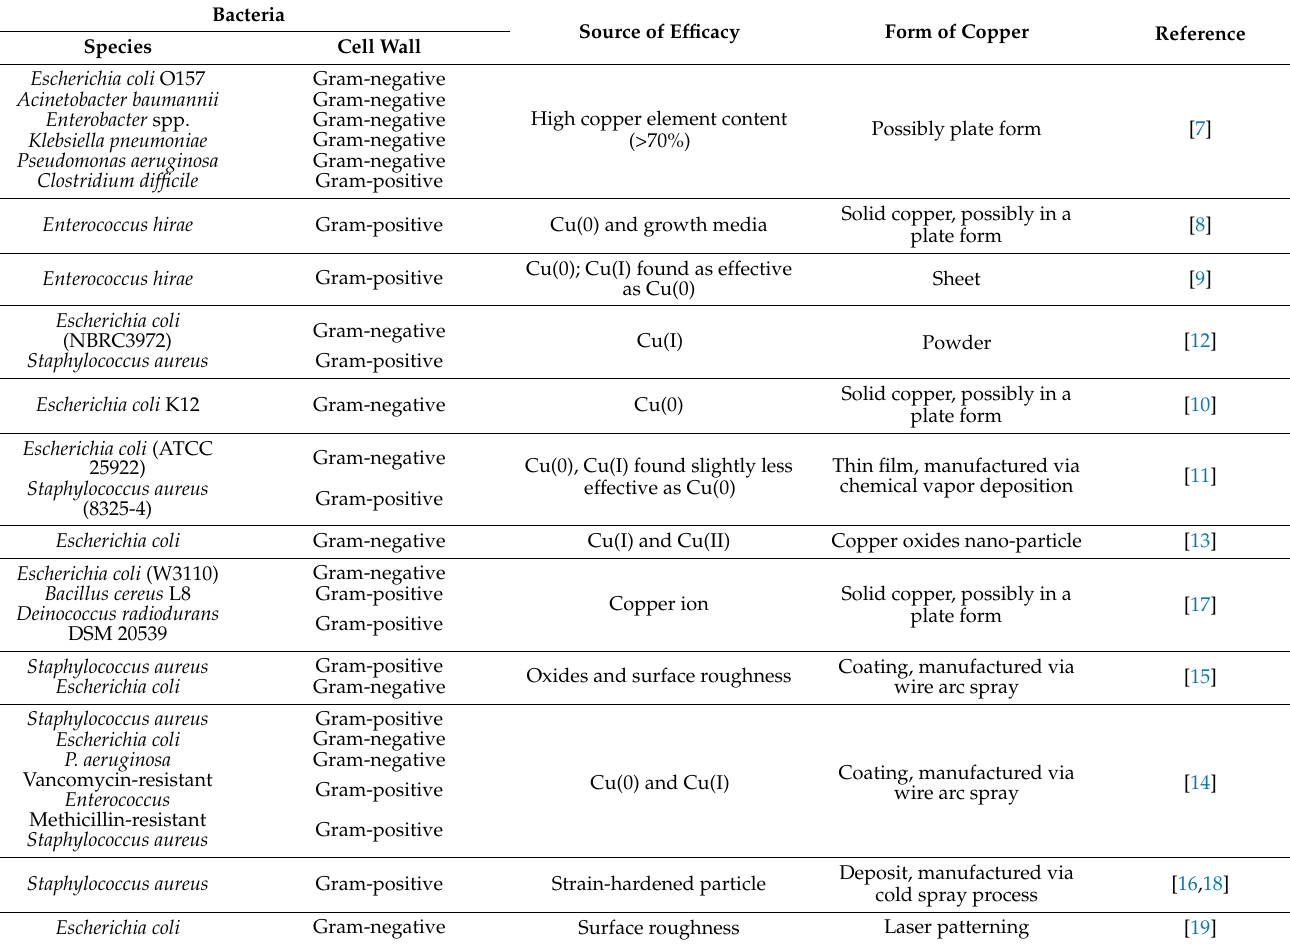
Table 1. Antibacterial properties of